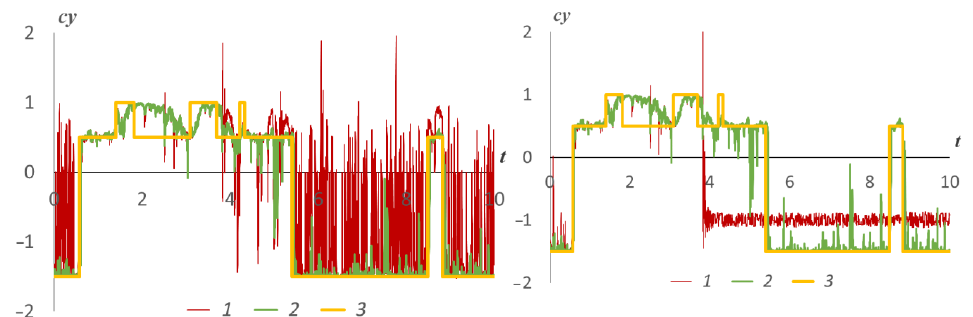
Figure 7. The heuristic modification of the Euler–Maruyama scheme with respect to the stable one and true input: ( left ) 1—heuristic estimate (cid:98) y lim